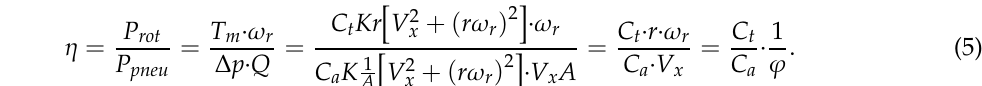
Figure 6. Simulink model with rotor and wind speeds as inputs, and power and torque at the shaft as outputs.